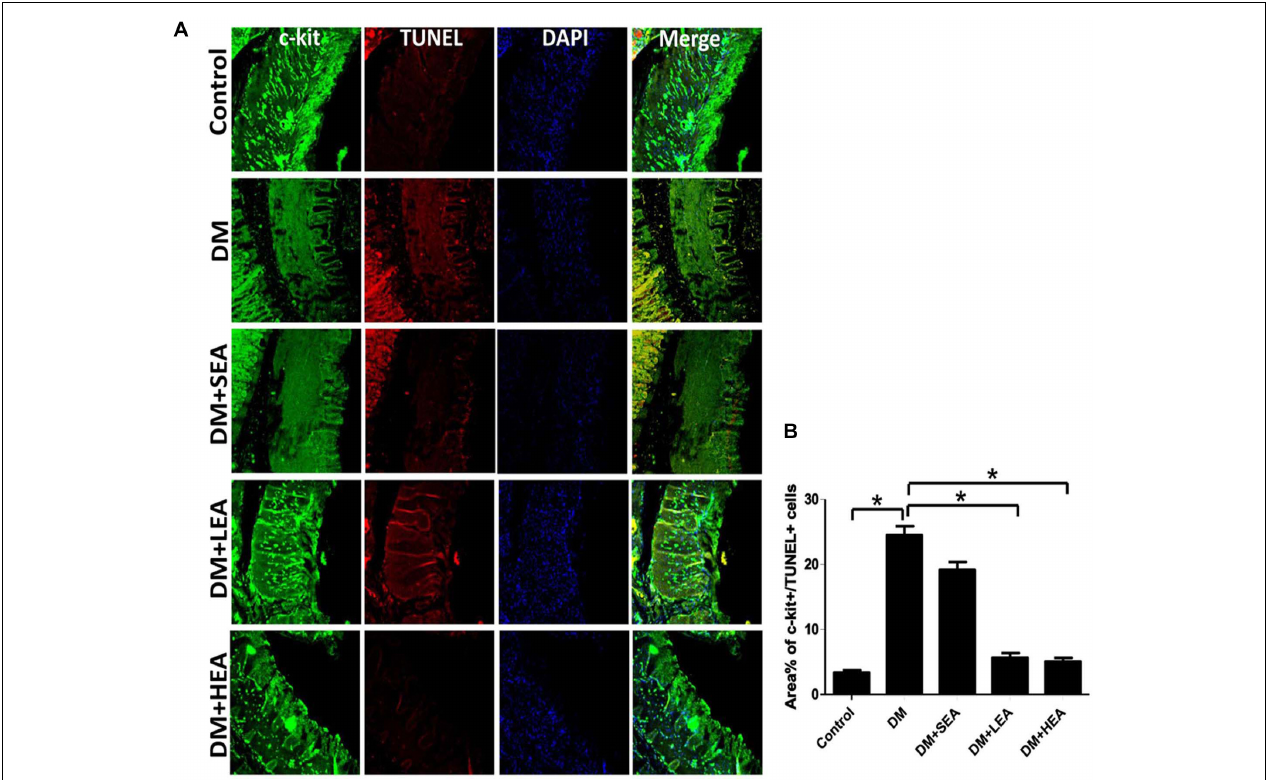
FIGURE 3 | Confocal micrographs of apoptotic interstitial cells of Cajal (ICC) labeled with c-kit (green), TUNEL (red), and DAPI (blue). (A) In the control group, many c-kit + cells were observed in the gastric wall, but a few of c-kit + /TUNEL + cells were found. The number of ICC was decreased in the DM and diabetic and sham EA (DM + SEA) group. A few apoptotic ICC was seen in the DM + LEA and DM + HEA groups. Scale bars = 20 mm. (B) Quantification of c-kit + /TUNEL + cells in the stomach of each group. One-way ANOVA was used to analyze the data, and the Dunnett T3 post hoc test was used for the analyses. * P < 0.05 compared with the DM group.